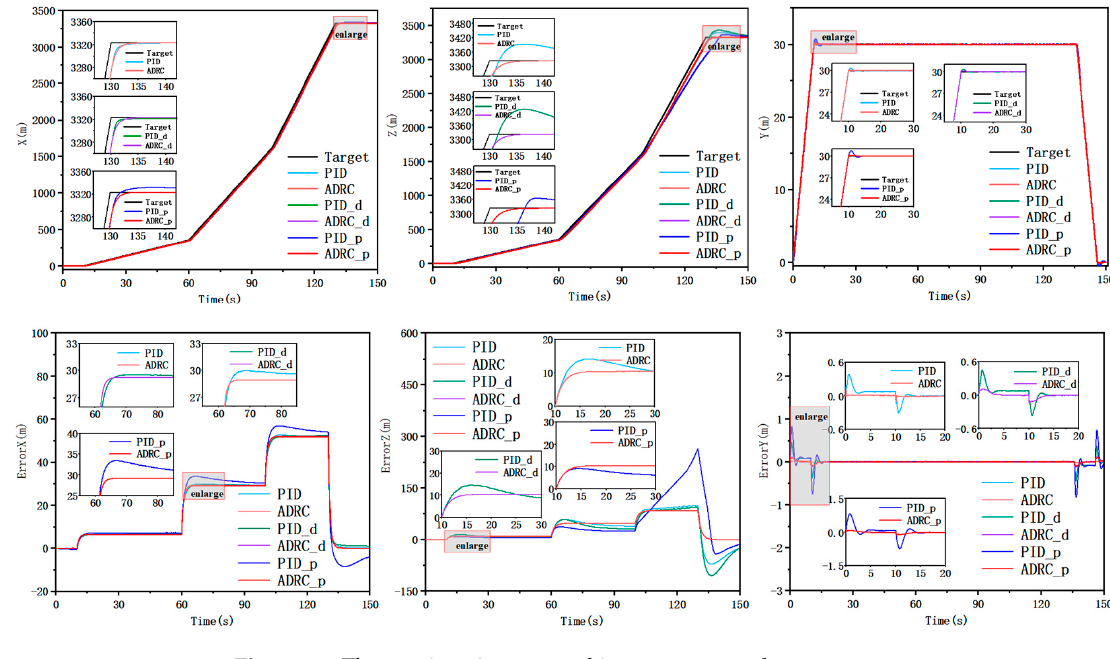
Figure 11. Three-axis trajectory tracking response and error.